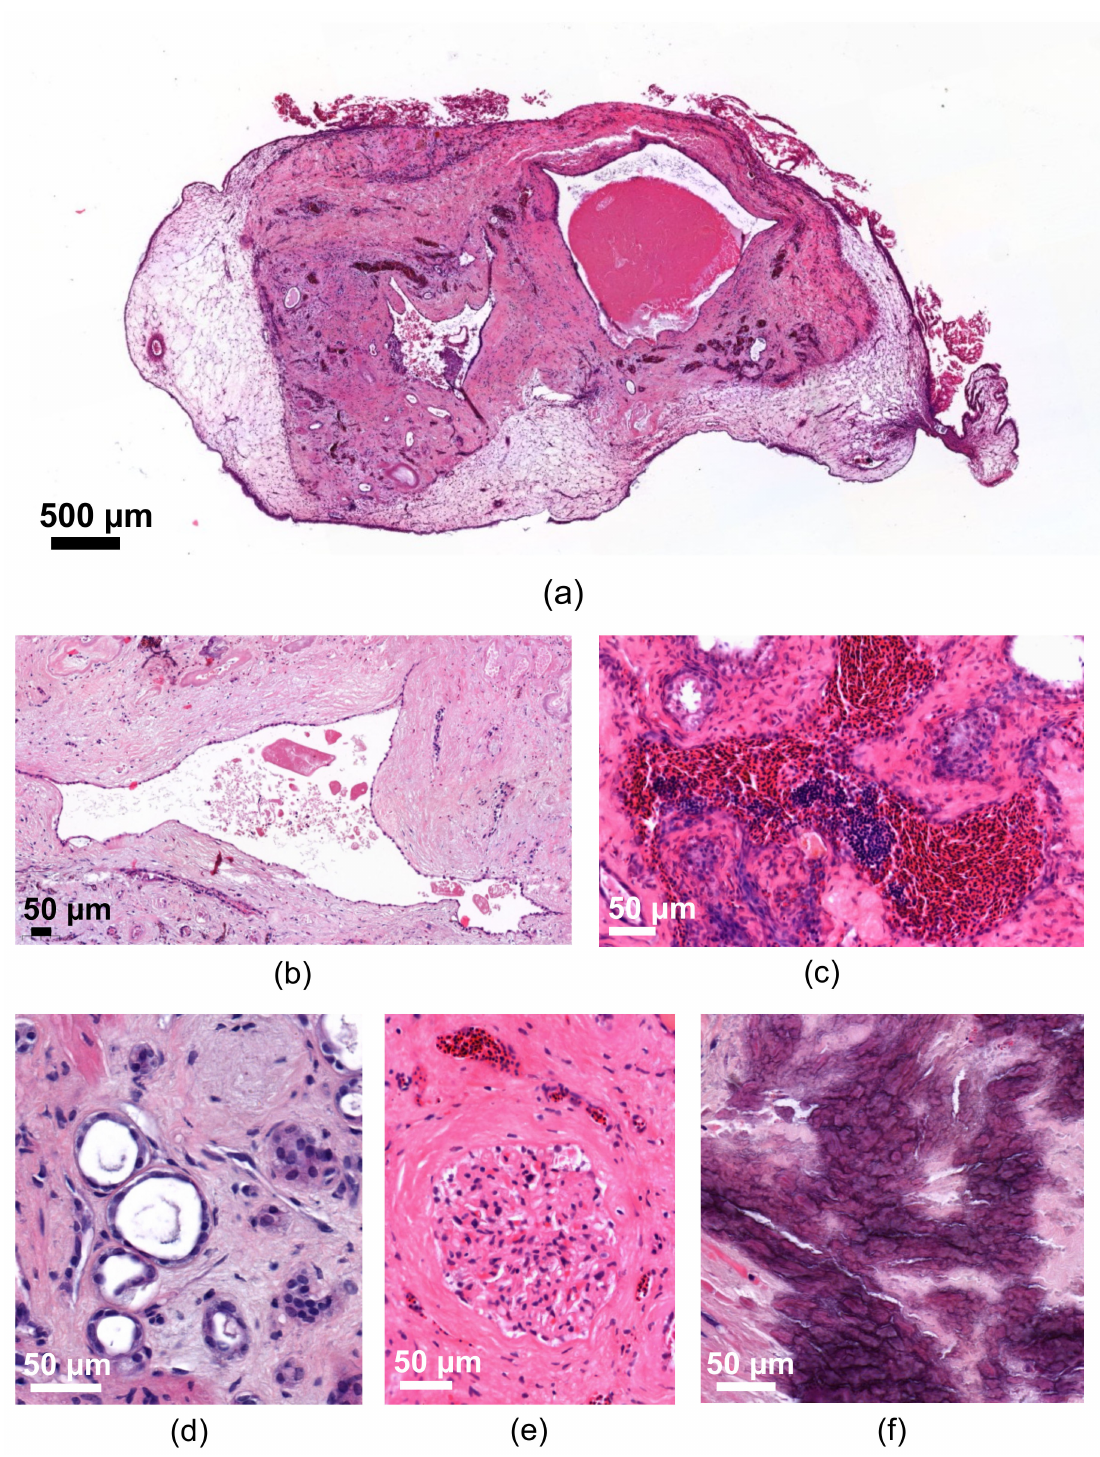
Figure 11. Representative H&E staining of human cystic tissue after removal from the CAM; ( a ) overview showing cystic tissue with two bigger cysts within the renal tissue surrounded by the CAM; ( b ) cyst with a typically flat epithelium and intraluminal debris; ( c ) accumulation of erythrocytes in a cyst; ( d ) vital parts of the tubule system; ( e ) vital glomerulus; and ( f ) bradytrophic